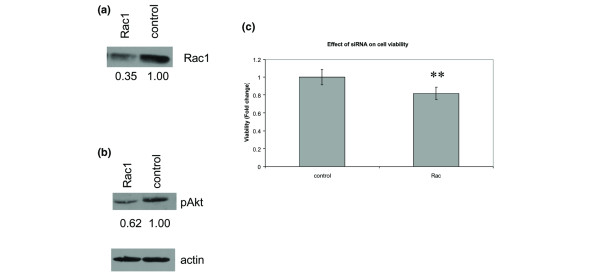
siRNA-directed inhibition of Rac1 reduces synovial fibroblast viability and pAkt levels. Synovial fibroblasts were transfected with siRNA against Rac1 or a non-silencing RNA as control, and cultured for 96 hours at which point XTT assays were performed to measure cell viability and lysates were prepared from wells that had been transfected in parallel. (a, b) Lysates were subjected to immunoblotting and probed with anti-Rac (a) or anti-pAkt or actin (b) for normalization. (c) Effect of siRNA on cell viability. ** p < 0.01 for viability of synovial fibroblasts transfected with non-siRNA control versus Rac1 siRNA. Shown is a representative of three independent experiments. siRNA transfection efficiency was greater than 95%.